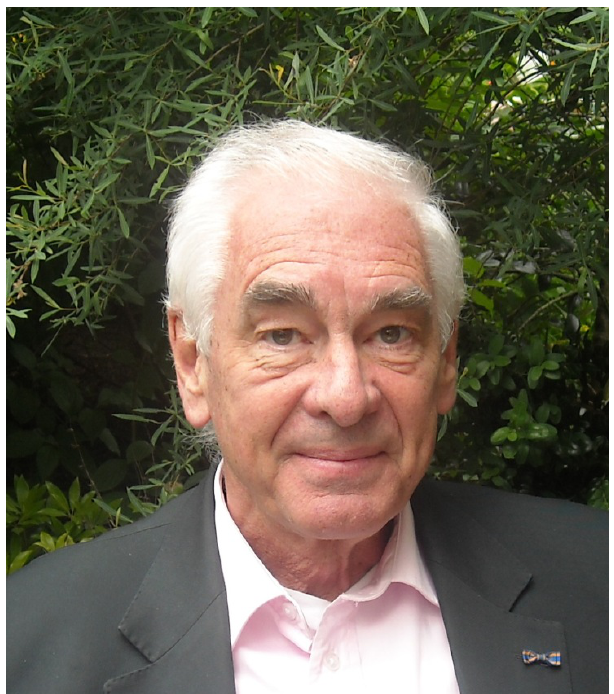
Figure 1. Robert Kaptein